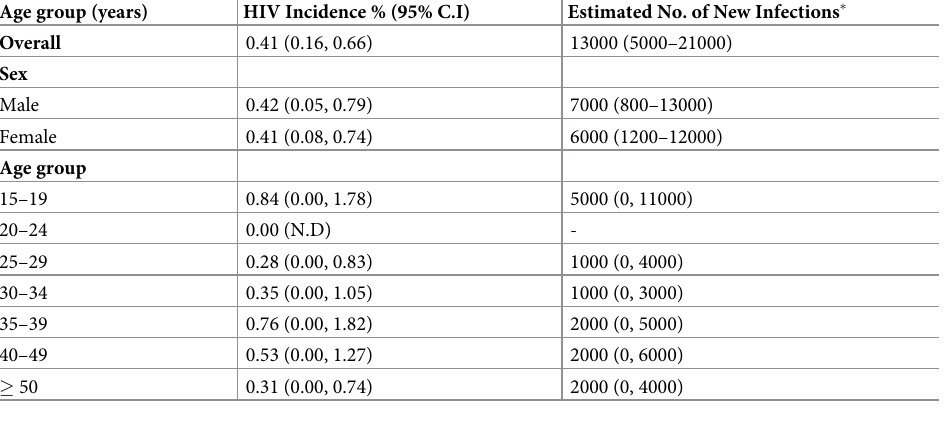
Table 5. HIV Incidence (percentage) and number of new infections by age and sex among adults 15 years and